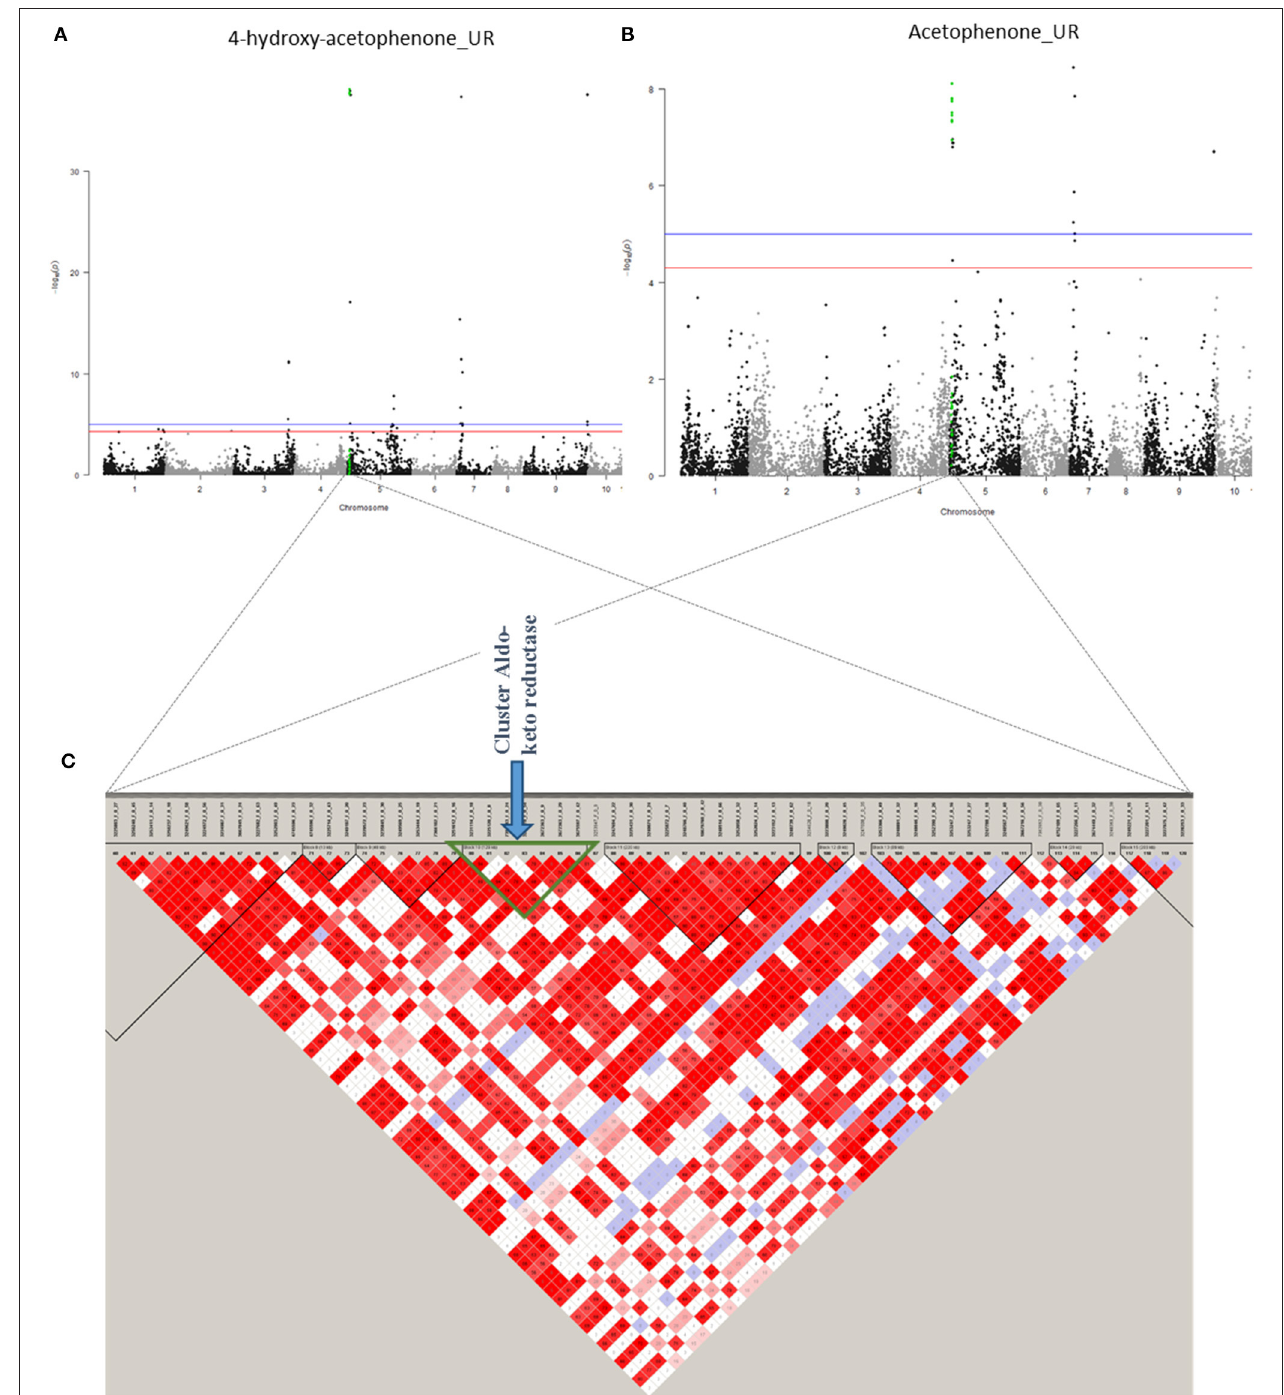
FIGURE 8 | Co-localisation between 4-hydroxy-acetophenone (UR) and acetophenone (UR) with candidate genes. (A) Manhattan plot representing association results for the trait 4-hydroxy-acetophenone (UR). (B) Manhattan plot representing association results for acetophenone (UR). (C) Heat map of a part of chromosome 5. The common region of association is represented by a green